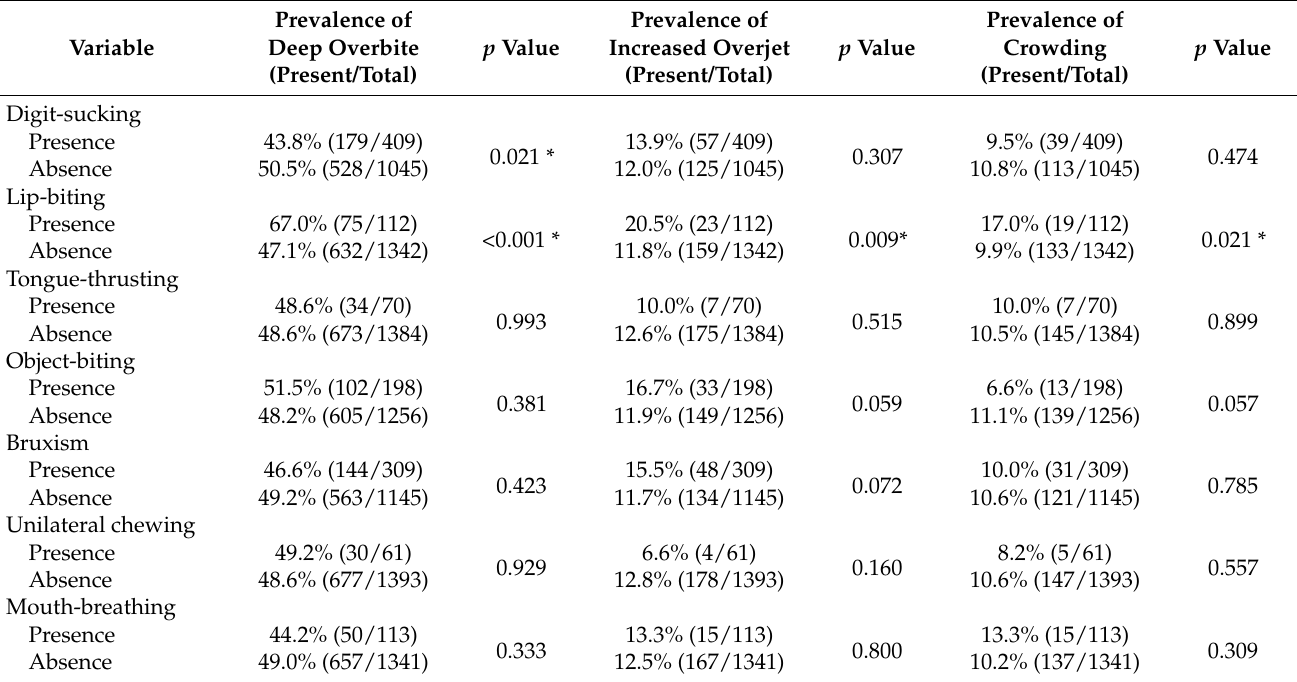
Table 4. Association between deleterious oral habits and malocclusion.